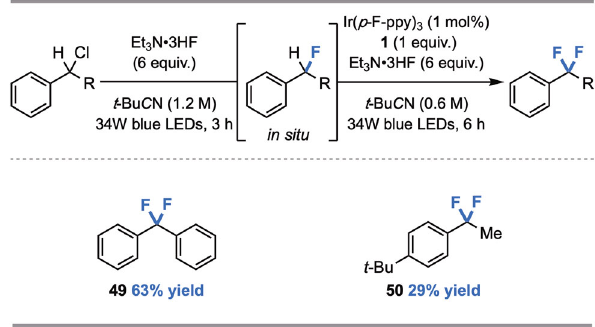
Fig. 3 Scope of C(sp 3 ) – H di fl uorination (0.25 mmol scale, 19 F NMR yield). See Supplementary Information for